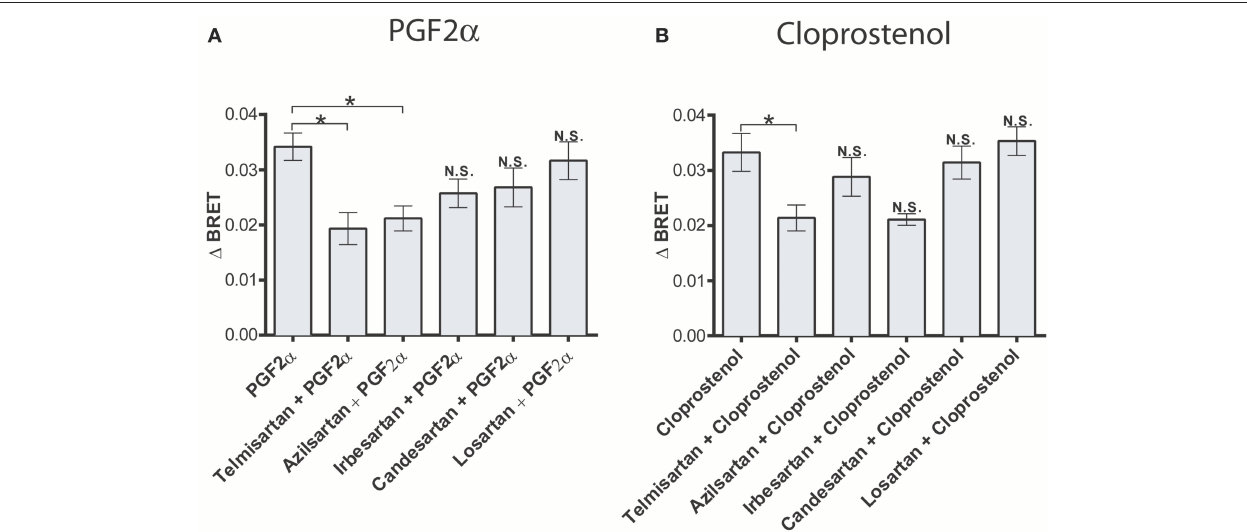
FIGURE 4 | Biased allosteric regulation of the PGF2 α - and cloprostenol-induced β -arrestin2 recruitment to the AT 1 R/FP dimer by AT1R antagonists. (A) Pretreatment (1 µ M for 30min) with telmisartan or azilsartan allosterically inhibited recruitment of β -arrestin 2-RlucII to the AT1R-Venus/FP-WT dimer in response to PGF2 α (1 µ M). Under the same experimental conditions, irbesartan, candersartan and losartan produced no allosteric effects. (B) Pretreatment (1 µ M for 30min) with telmisartan allosterically inhibited the recruitment of β -arrestin 2-RlucII to the AT1R-Venus/FP-WT dimer in response to cloprostenol (1 µ M). Under the same experimental conditions, azilsartan, irbesartan, candersartan and losartan produced no allosteric effects. Data represent mean ± s.e.m. of independent experiments [biological replicates performed in triplicate ( n = 3–6)]. * p < 0.05. N.S.,